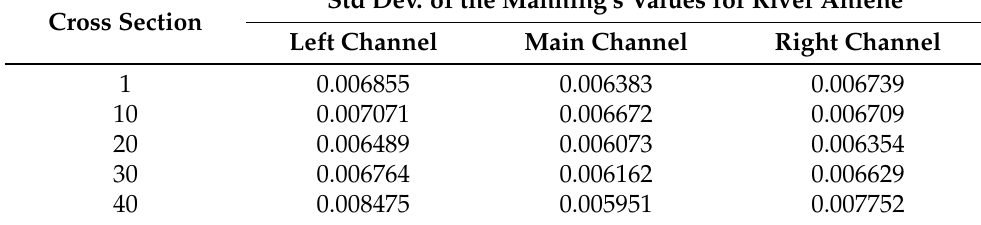
Table 4. Standard deviations of the Manning’s values obtained by the 25 executions of the (1 + 1)-ES algorithm for the case of study ‘river Aniene’. For the sake of readability, five cross-sections were reported, though the magnitude of the standard deviations is roughly the same for all the other